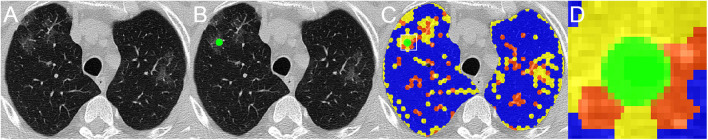
A representative CT scan axial image of a COVID-19 patient (A), the region of interest (ROI), in green, classified by one radiologist as ground glass opacities (GGO) (B), and the overlapping of radiologist's ROI and the grid of regular hexagons with radii of 4 mm (C), with each grid already classified as well-aerated regions (blue), GGO (yellow), and CP/LO (orange) areas. (D) Amplification of the overlapped region marked with the white square in (C). Note that, within ROI, there are voxels of two different classes, GGO in yellow and CP/LO in orange. For comparison purposes, the ROI region is classified as the most prevalent voxel class, in this case as GGO class.